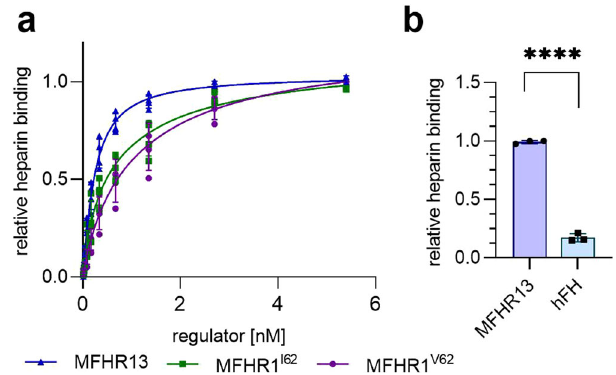
Fig. 5 MFHR13 binds better to heparin than MFHR1 I62 , MFHR1 V62 , or hFH. a Heparin binding was evaluated by ELISA. Nonlinear regression using the sigmoidal equation (dose – response curve, 4 parameters) and comparison of IC 50 showed signi fi cant differences between MFHR13, MFHR1 I62 , and MFHR1 V62 binding to heparin ( P < 0.0001 both comparisons). Data represent mean values ± SD from 4 independent experiments. The blank (BSA 2%) was subtracted from all the samples. Data from one representative experiment are shown in Supplementary Fig. 8a. b MFHR13 binds signi fi cantly better to heparin than hFH ( P < 0.0001, unpaired t -test). The binding was measured by ELISA using 25 nM of hFH or MFHR13,